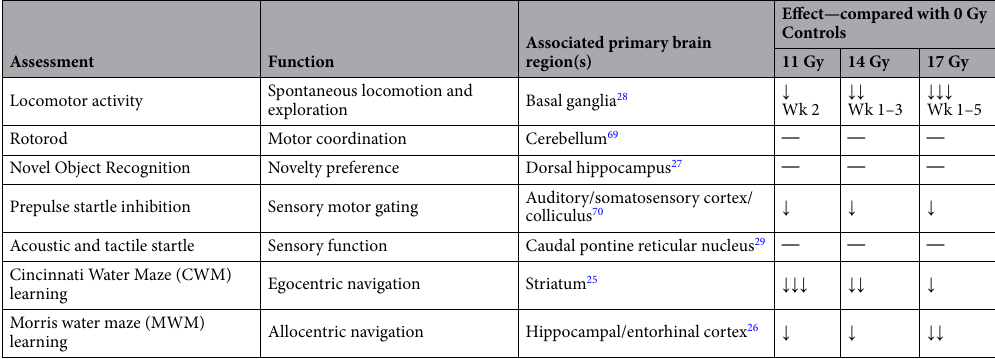
Table 3. Summary of effects of whole brain single fraction conventional proton